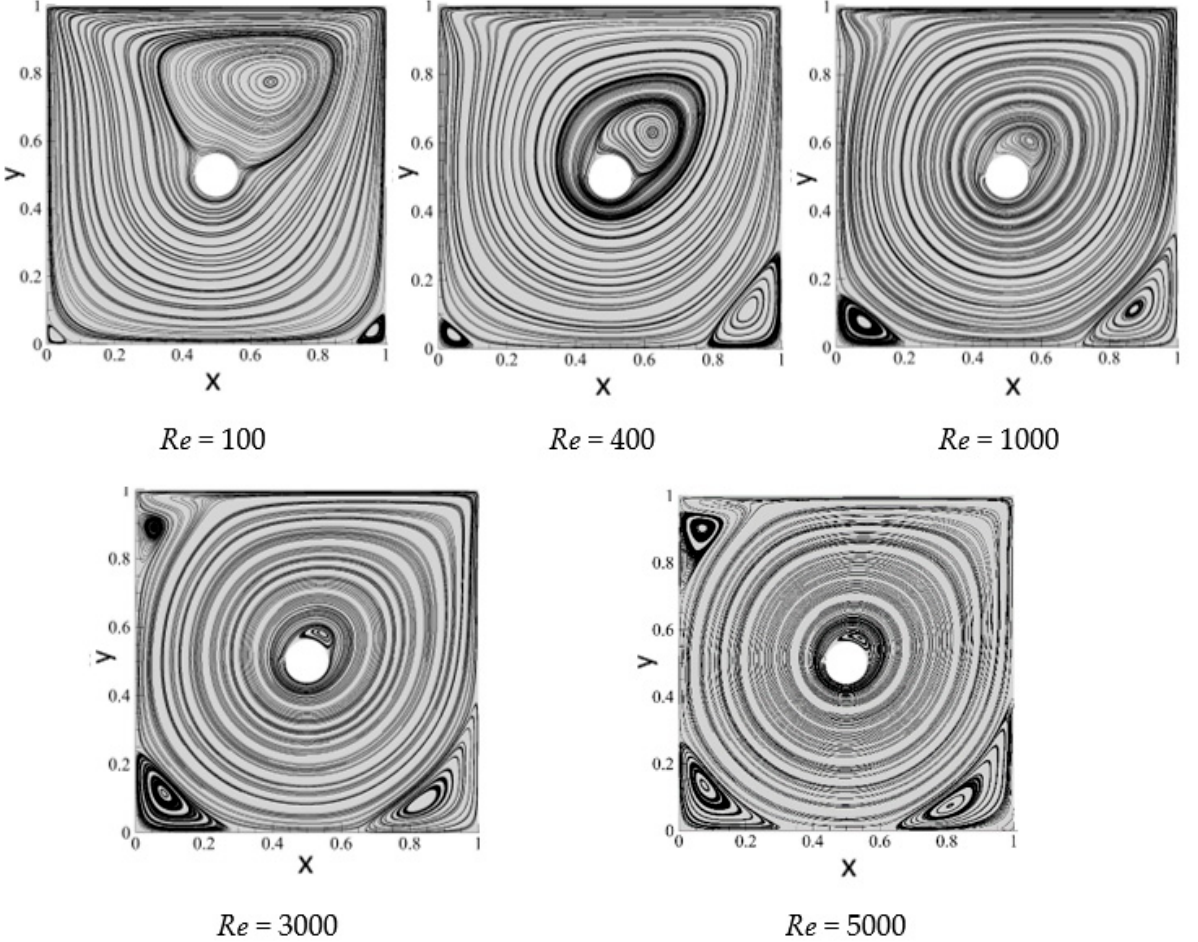
Figure 4. Streamlines of the lid-driven square cavity flow with an embedded circular obstacle at various Reynolds numbers at r = .